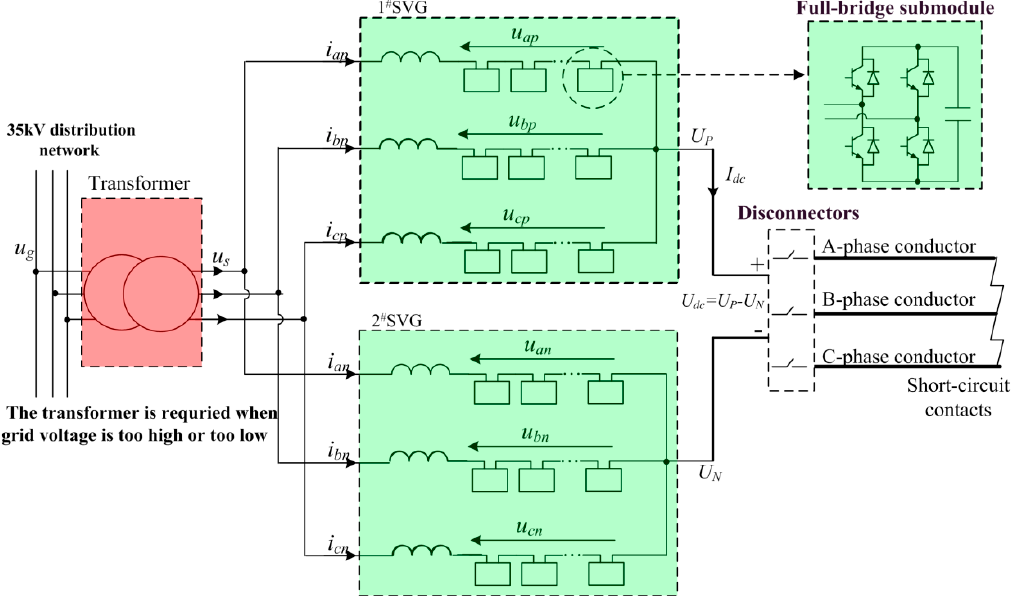
Figure 4. The proposed configuration structure of MMC-DDI.